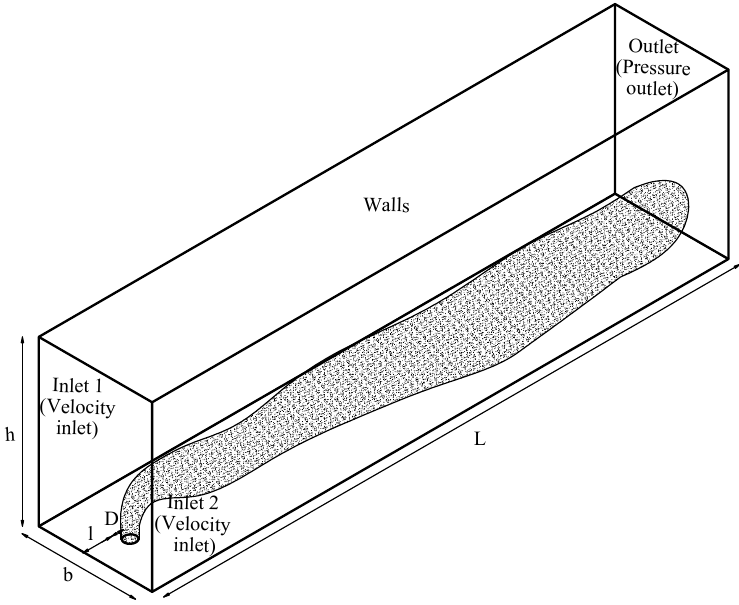
Figure 6. Wind tunnel domain considered in the simulations and boundary